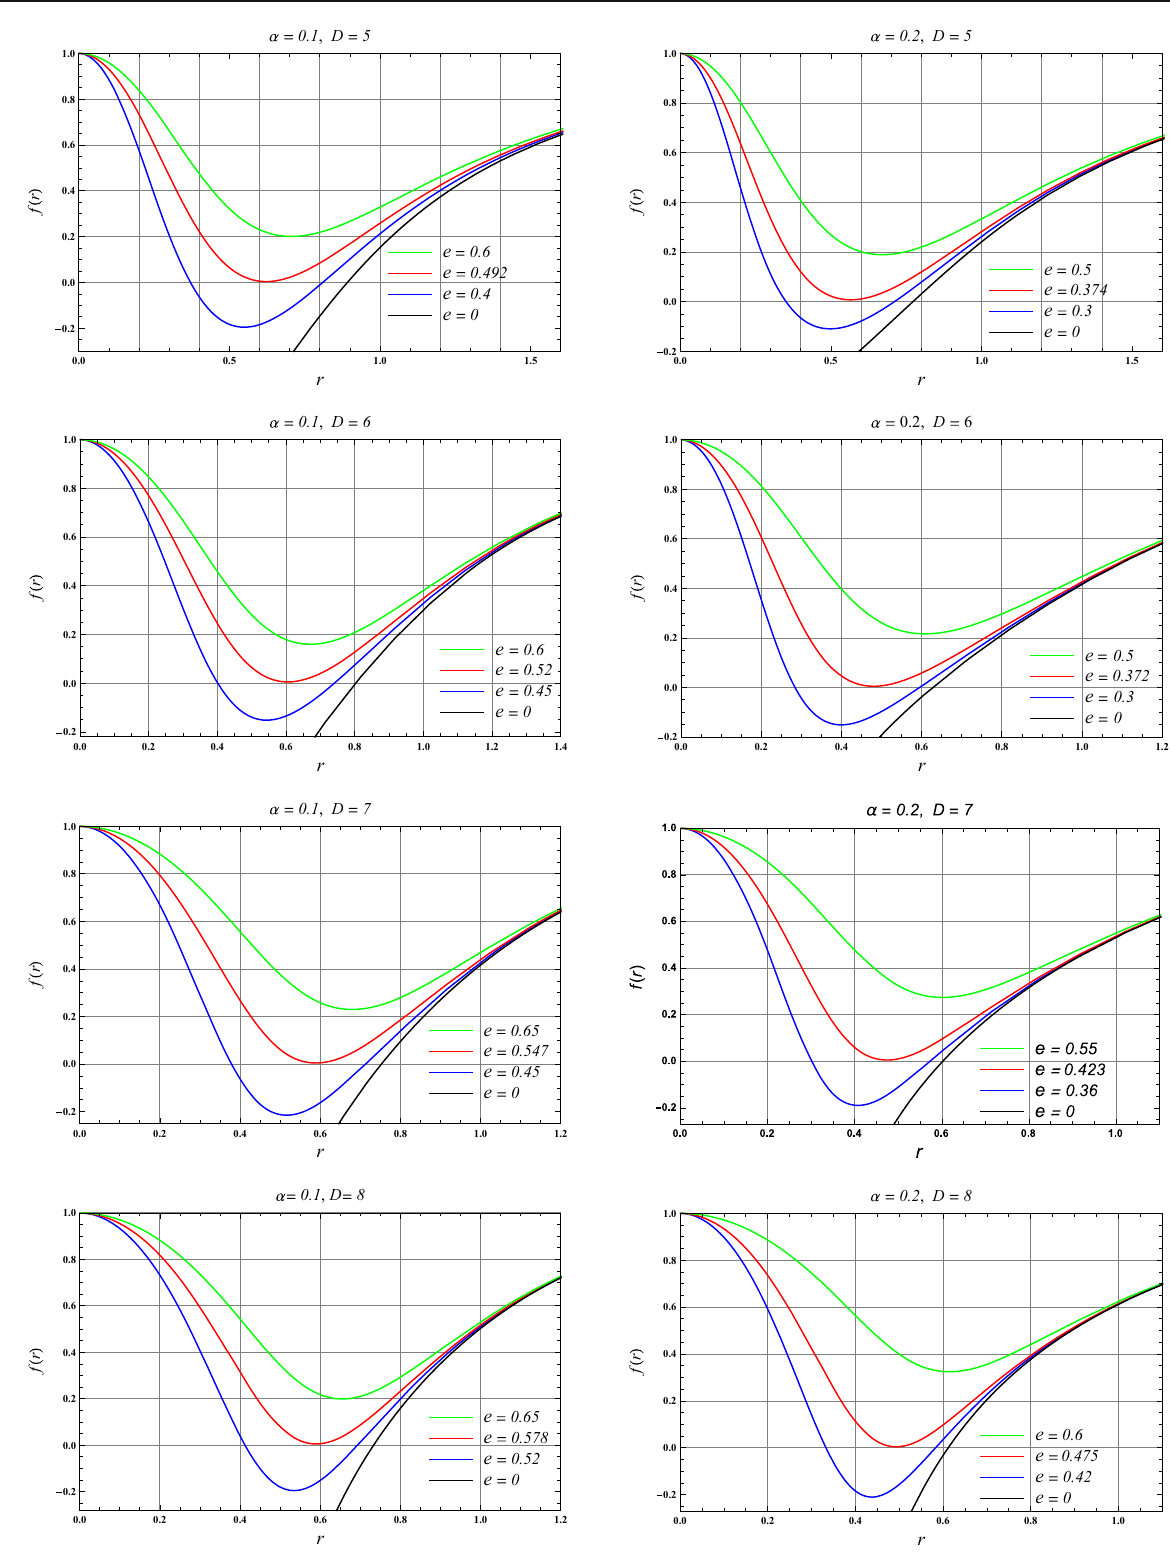
Fig. 1 Plot of metric function f − ( r ) vs r in various dimensions D = 5, 6, 7, and 8 (top to bottom) for different values of charge e with Gauss–Bonnet coupling α = 0.1 and 0.2 (left to right) with μ (cid:9) =